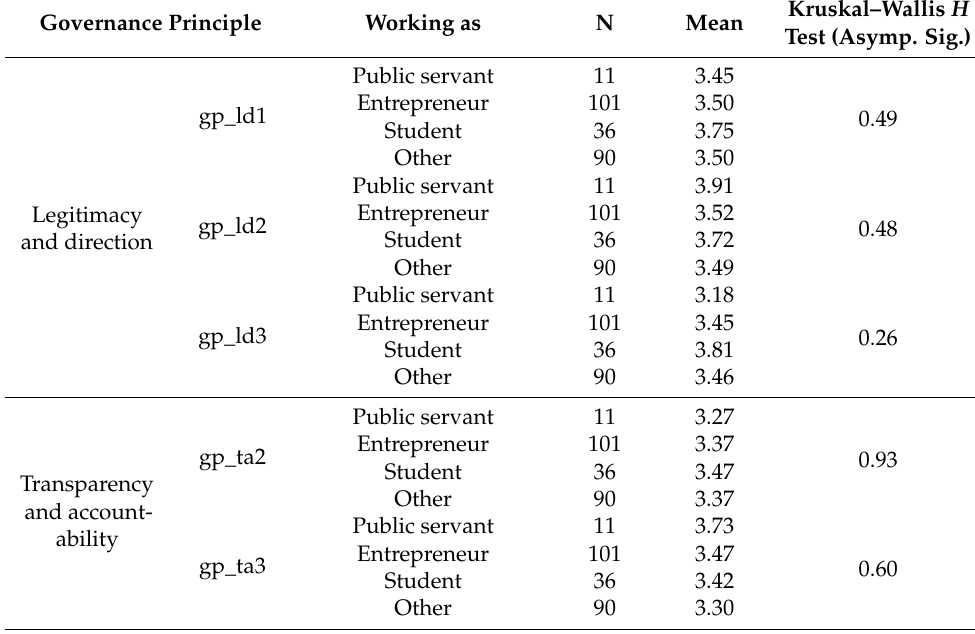
Table 12. Test of difference: